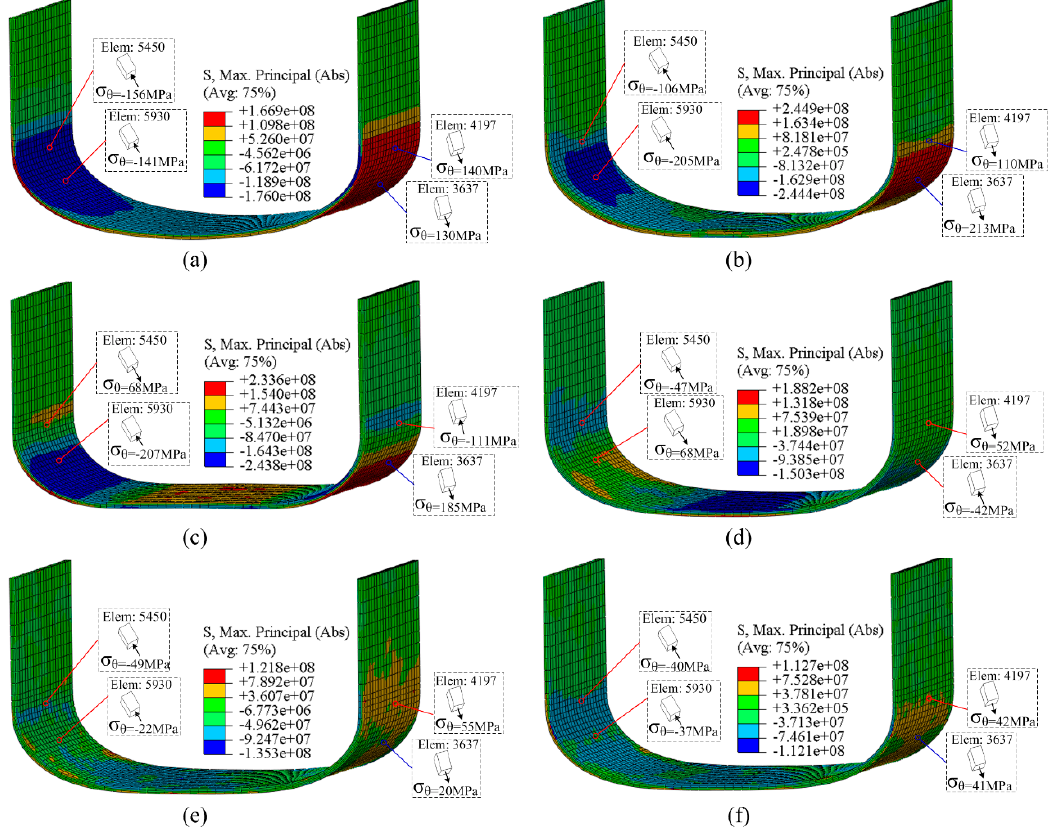
Figure 6. Distribution of tangential stresses in the sheet for 1.5 kV at different times: ( a ) 0 μ s, ( b ) 75 μ s, ( c ) 300 μ s, ( d ) 600 μ s, ( e ) 1500 μ s, and ( f ) 3000 μ s.